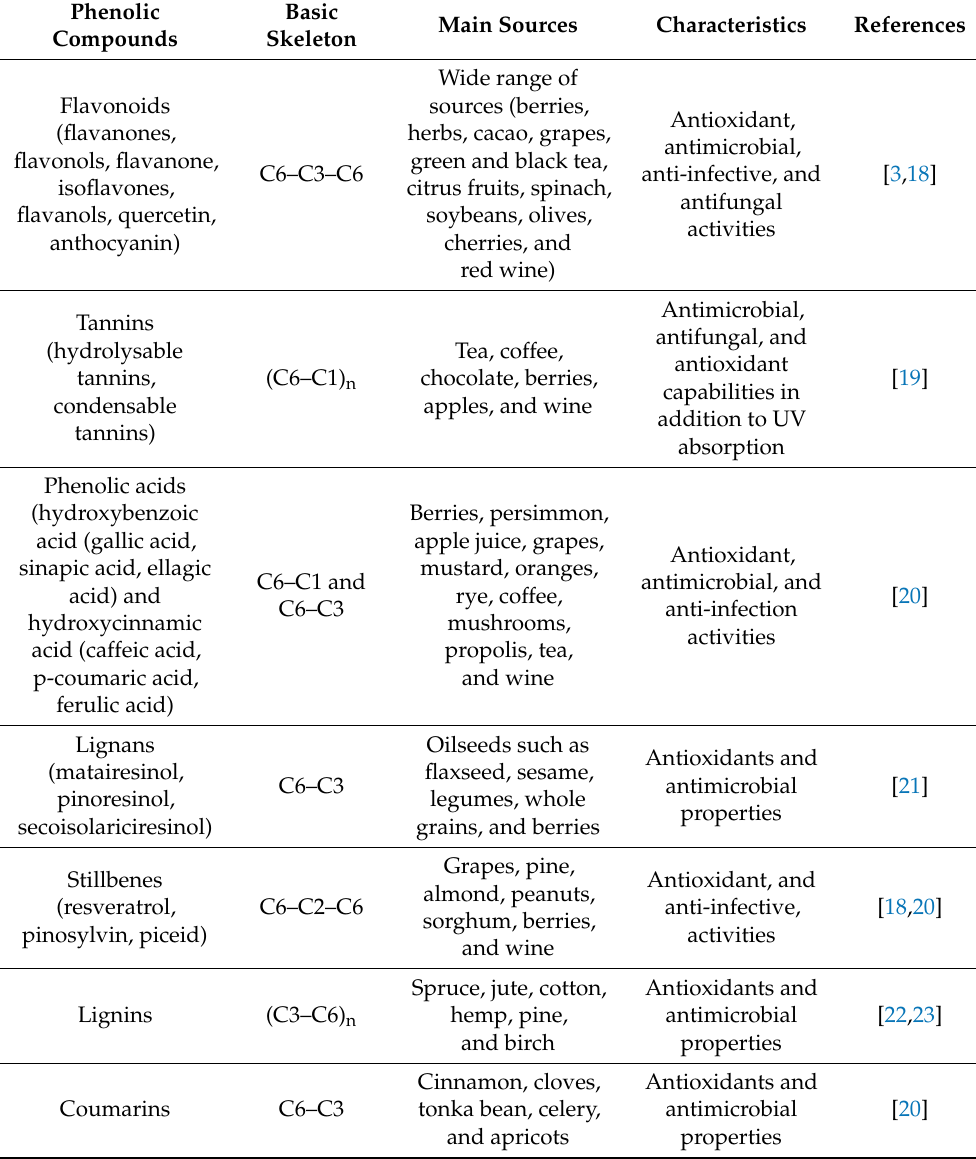
Table 1. Classification, basic skeleton, sources, and characteristics of phenolic